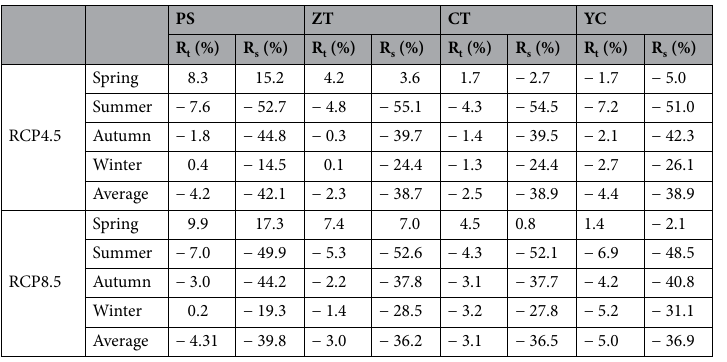
Table 11. Multiyear average changes (unit: %) of the R t and R s for the PS, ZT, CT and YC stations in different seasons under the RCP4.5 and RCP8.5 scenarios relative to the reference period.